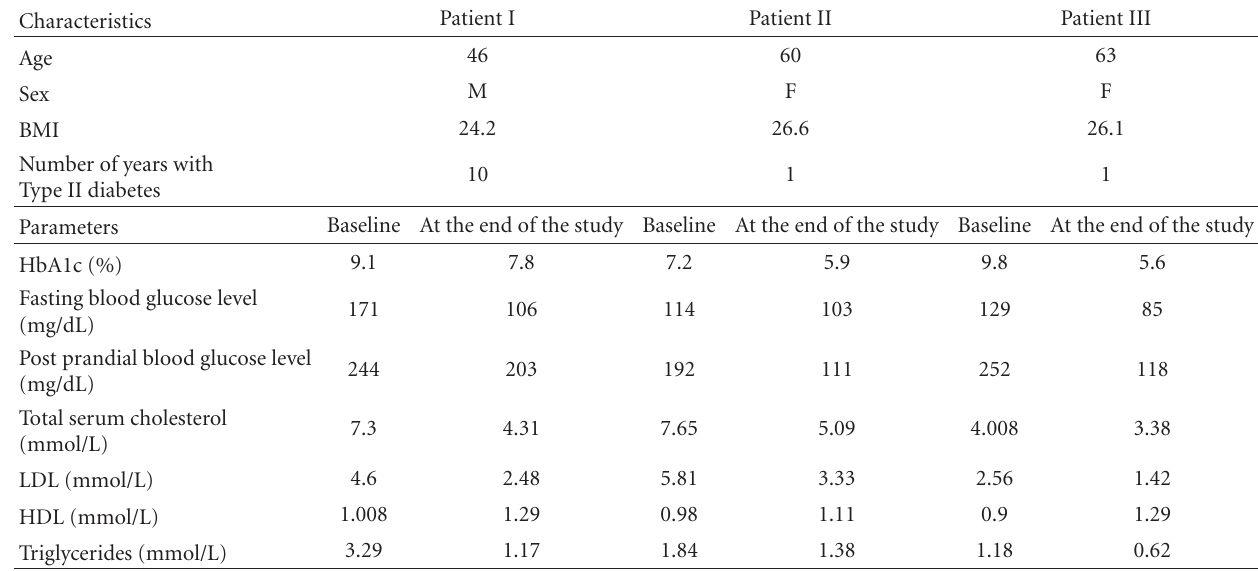
Table 1: Characteristics of patients and study parameters of relevance before and after food supplementation with Nichi Glucan. Characteristics Patient I Patient II Patient III